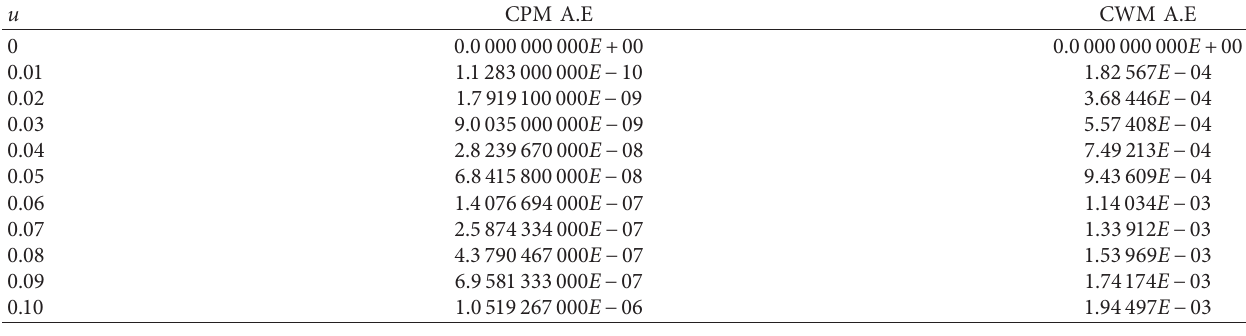
Table 2: Absolute error (A.E) comparison of CPM and other different methods of problem 1 at m � 4.